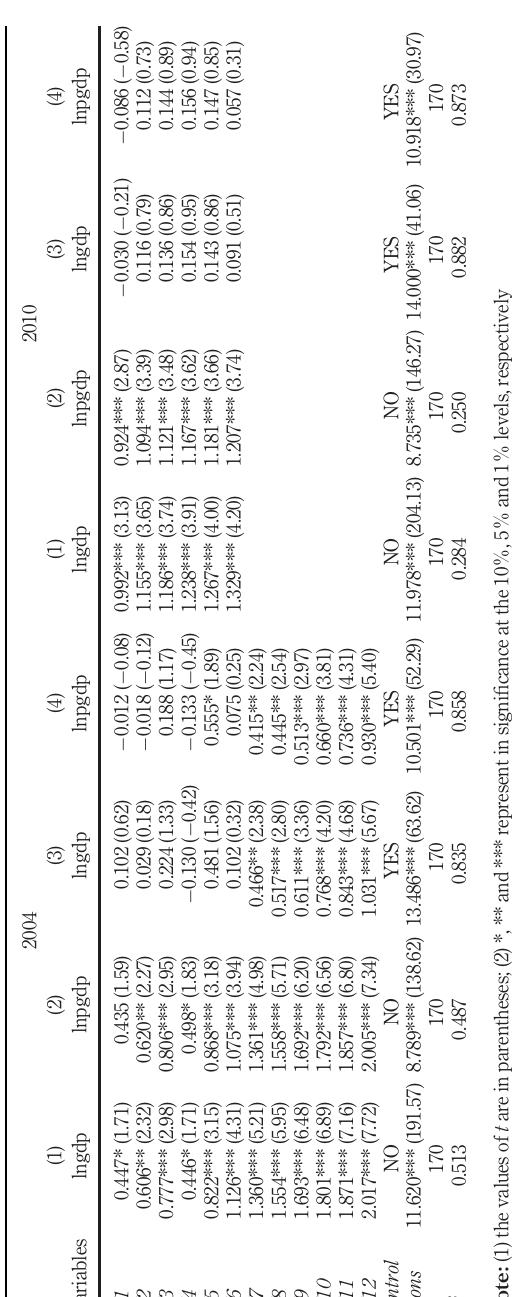
Table 5. Impact of the